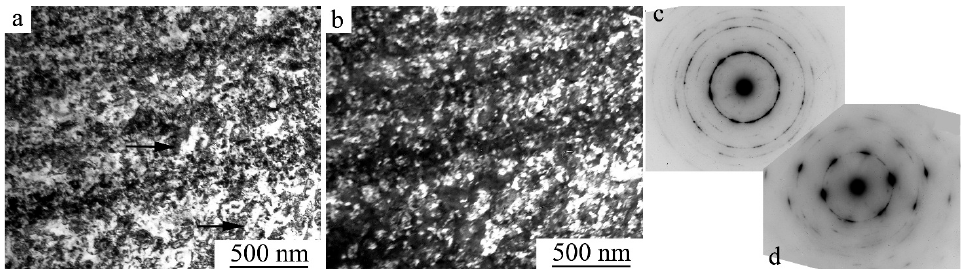
Figure 23. ( a ) Bright- and ( b ) dark-field TEM images, and ( c , d ) SAED patterns (( c )—SD 1.0 µm, ( d )— z.a. close to [111] В 2 , SD 0.3 µm), taken from the Ti 49 Ni 51 alloy after MPR by 30% and PDHT at 473 К for 1 h. Arrows point to «bright shining» areas. ( d )—z.a. close to [111] B 2 , SD 0.3 µ m), taken from the Ti 49 Ni 51 alloy after MPR by 30% and PDHT at 473 K for 1 h. Arrows point to «bright shining» areas.